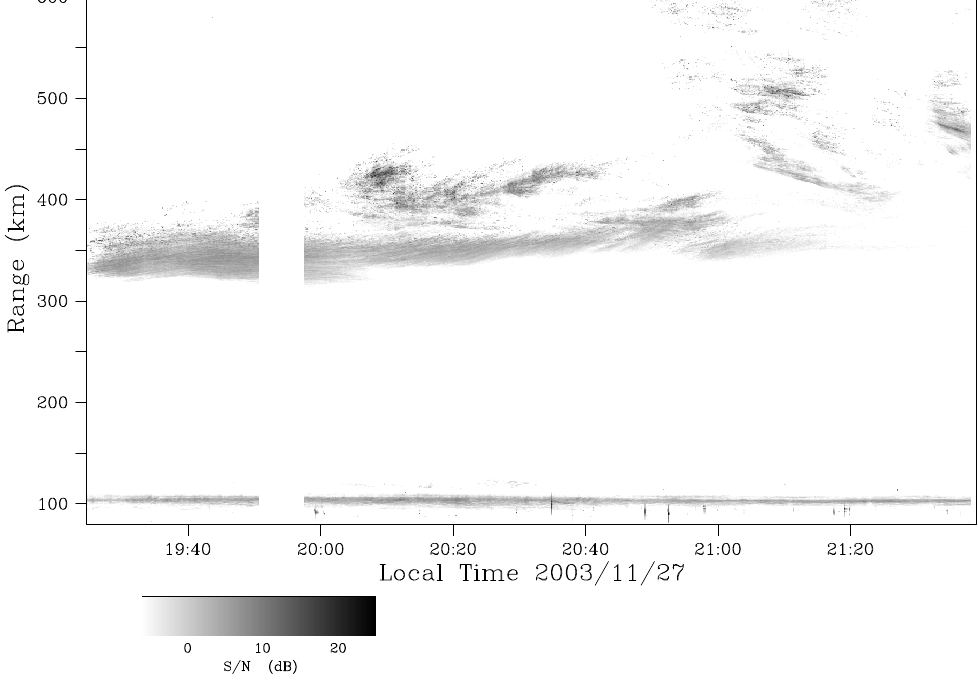
Fig. 2. RTI representation of a bottom-type scattering layer accompanied by emerging radar plumes after 20:00 LT and followed by topside ESF irregularities after 21:00